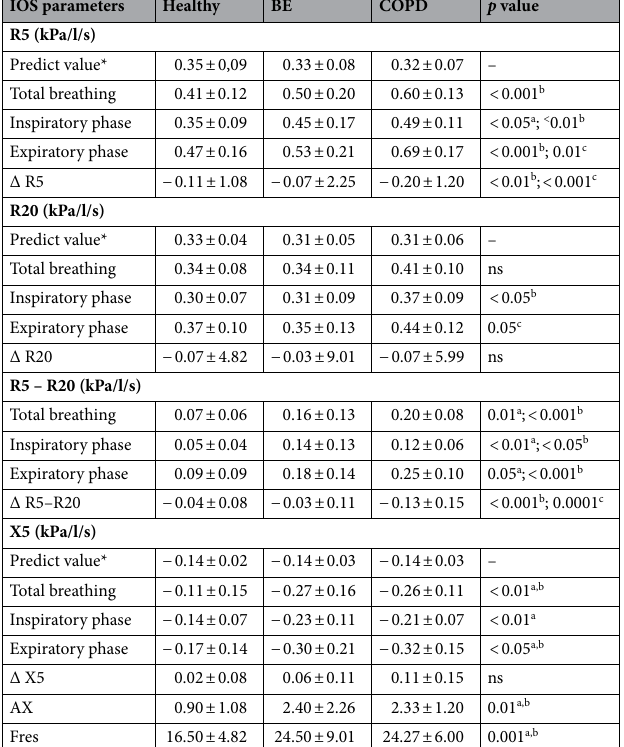
Table 2. Values of IOS parameters in all breathing phases. a Difference between Healthy and BE groups; b difference between Healthy and COPD groups; c Difference between BE and COPD groups. R5: total resistance; R20: central resistance; R5–R20: peripheral resistance; X5: reactance; AX: reactance area; Fres: resonance frequency. Healthy: no pulmonary disease; BE: bronchiectasis; COPD: chronic obstructive pulmonary disease. p value: Duncan post-hoc test. Predicted values*: calculated by age corrected, Oostveen et al. 15